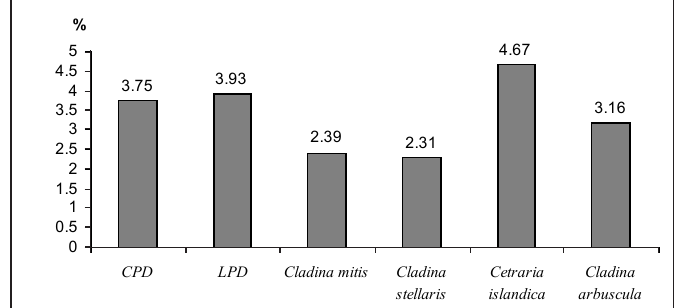
Fig. 1. Total fat content (mean values in %) in pellets and lichen (duplicate samples). Abbreviations: CPD: conventional pellet diet; LPD: linseed pellet diet.